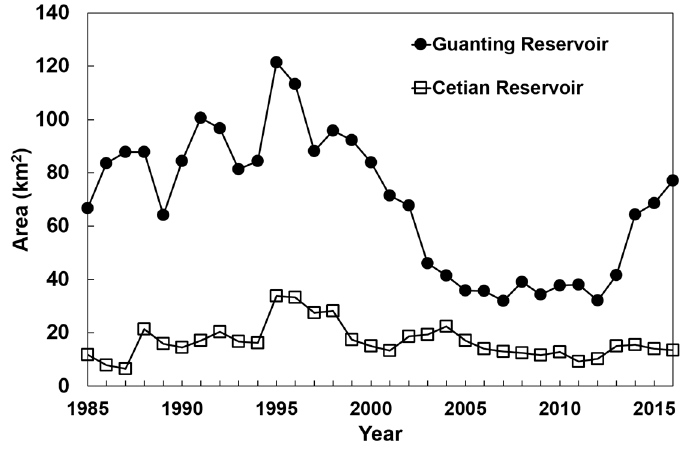
Figure 4. Statistics of reservoir water extents in YDRB.